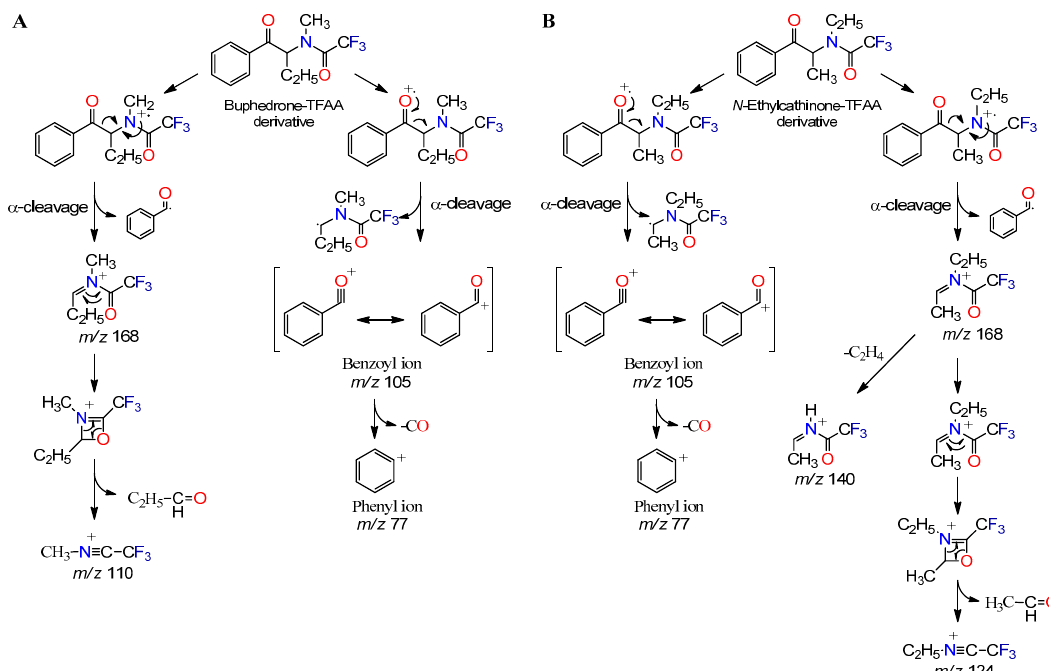
Figure 6. Probable fragmentation pathways of TFAA derivatives of, ( A ) buphedrone, and ( B ) N -ethylcathinone.